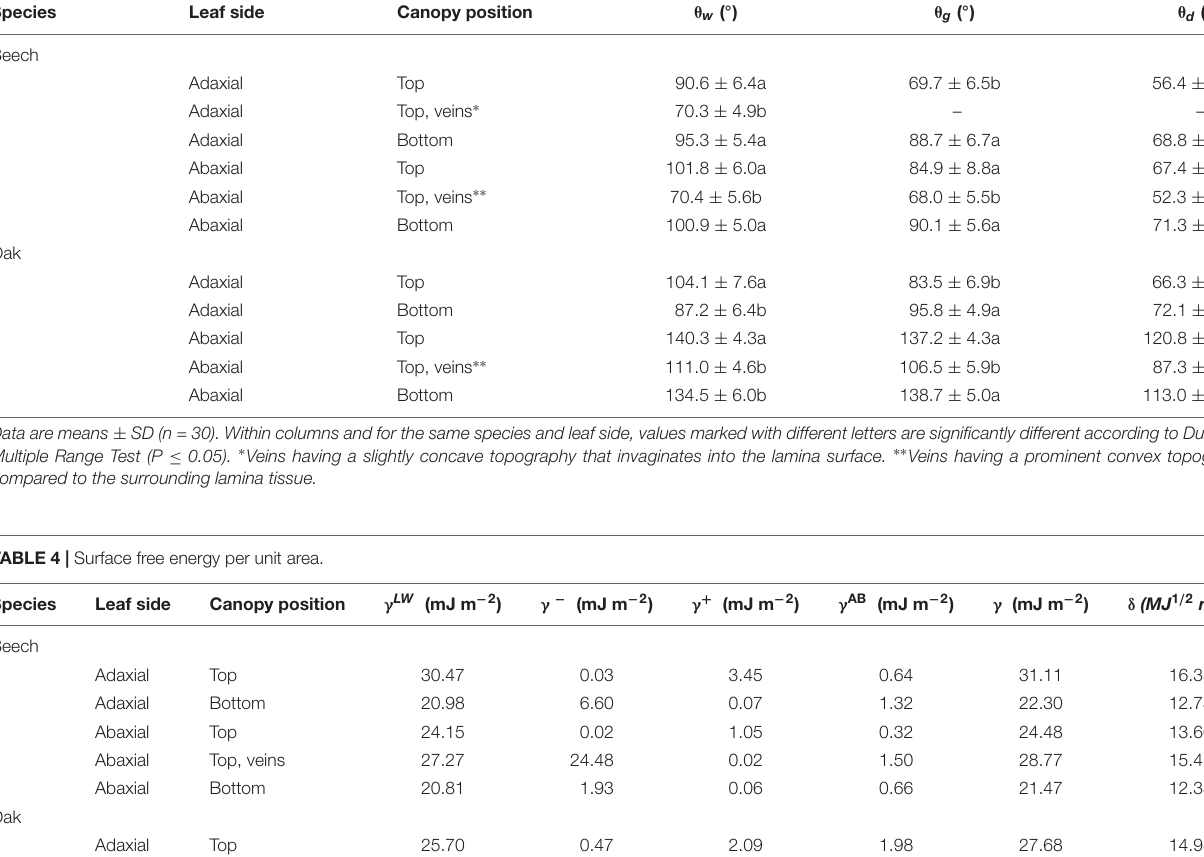
TABLE 3 | Contact angles of water ( θ w ), glycerol ( θ g ) and diiodomethane ( θ d ) with adaxial and abaxial lamina and vein surfaces of beech and sessile oak leaves collected from upper or lower tree canopy positions. Species